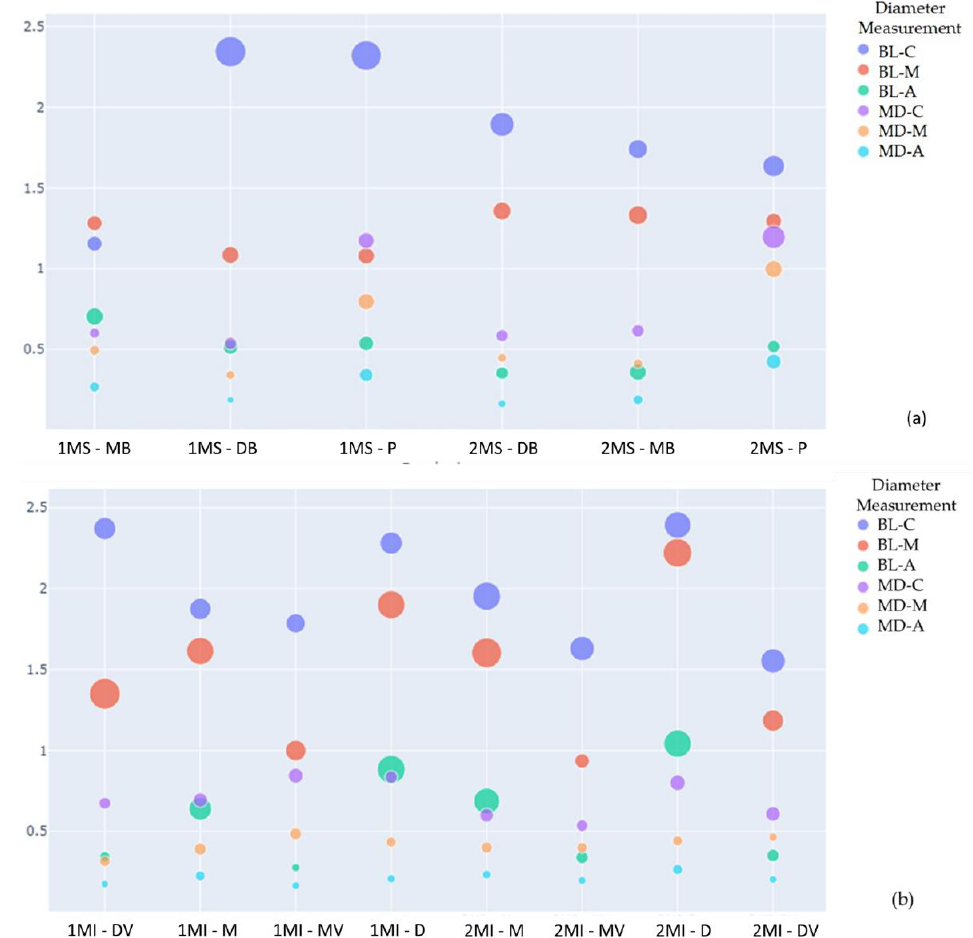
Figure 9. Scatter plot for comparison of each canal diameter. Where it is possible to observe the mean diameters of the canals in the buccolingual (BL) and mesiodistal (MD) directions at the three apical (A), middle (M), and cervical (C) levels of the canals of the upper molars. The size of the circumference indicates the increase in the standard deviation (SD). Axis Y: Diameter measurement (mm). Axis X: 1MS (Maxillary 1st molar); 2MS (Maxillary 2nd molar); 1MI (Mandibular 1st molar); 2MI (Mandibular 2nd molar); MB (mesiobuccal); DB (distobuccal); P (palatal root); M (mesial); D (distal); S (supernumerary); ( a ) Maxillary molar comparison; ( b ) Mandibular molar comparison.